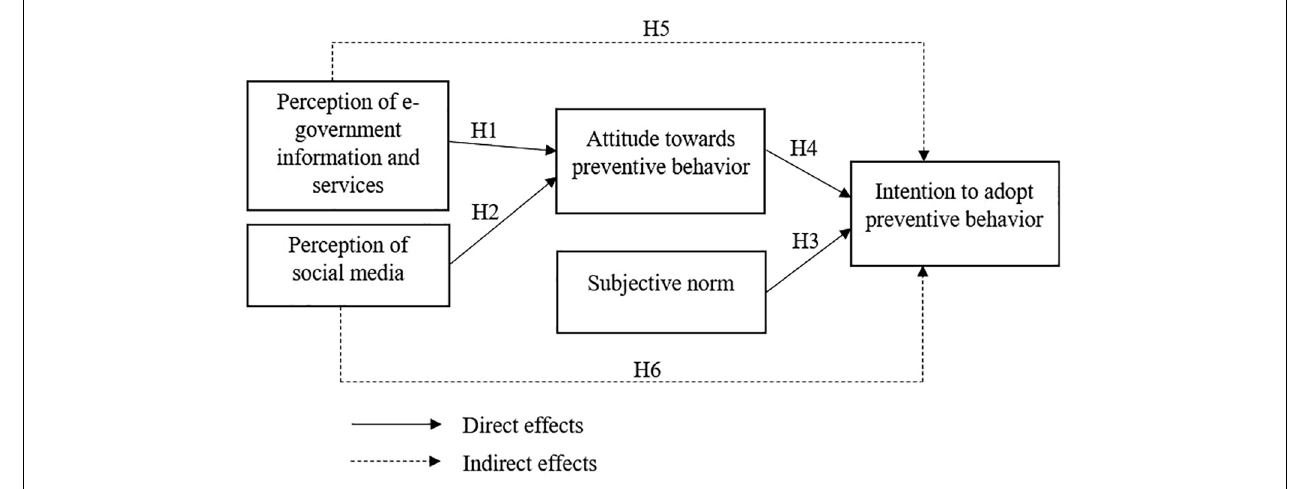
FIGURE 1 | Theoretical model.